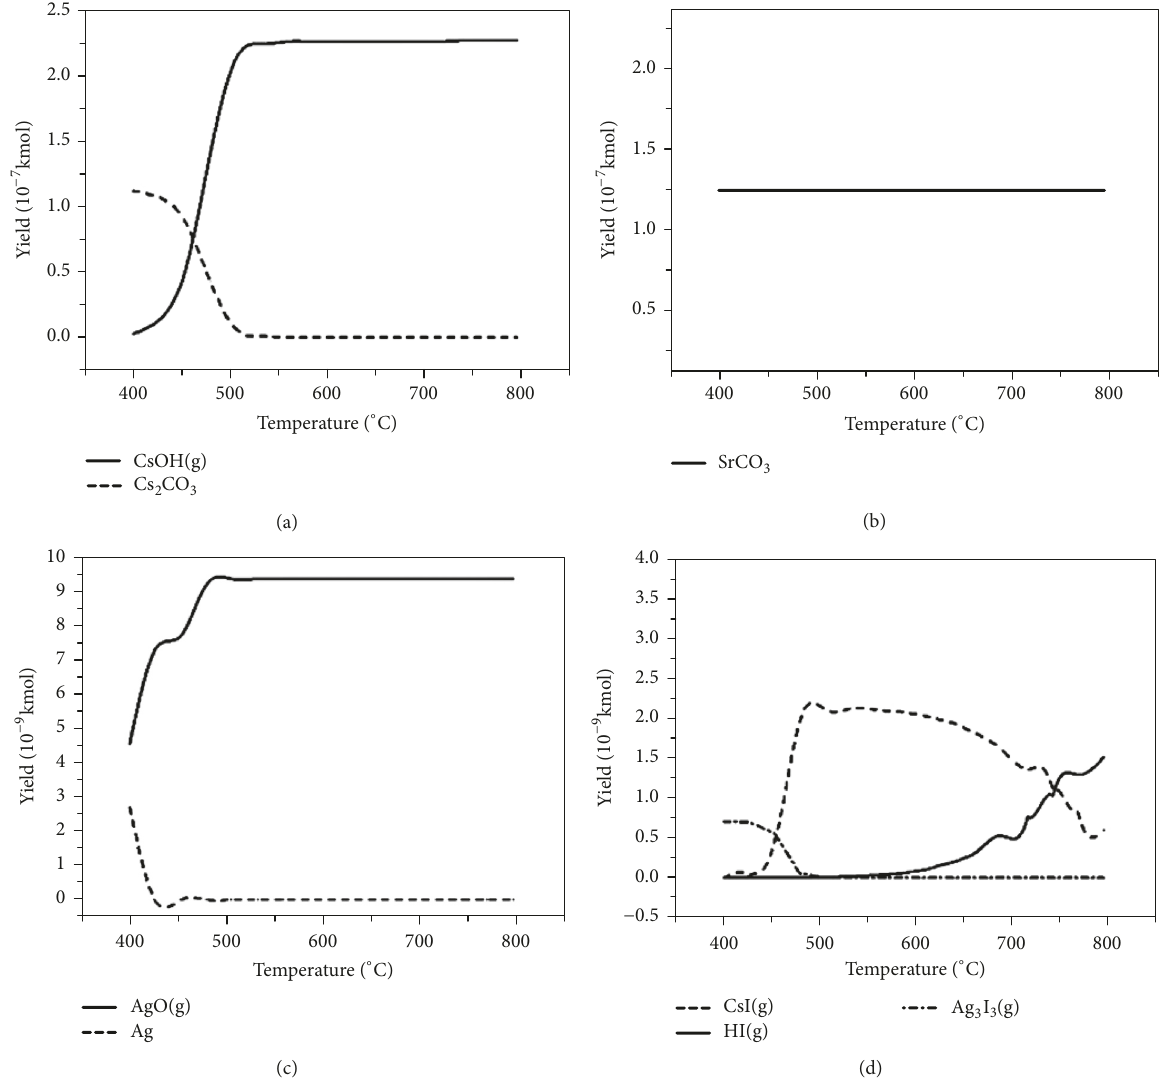
Figure 7: Variations in the chemical forms of 23h after water ingress accident: (a) Cs, (b) Sr, (c) Ag, and (d)